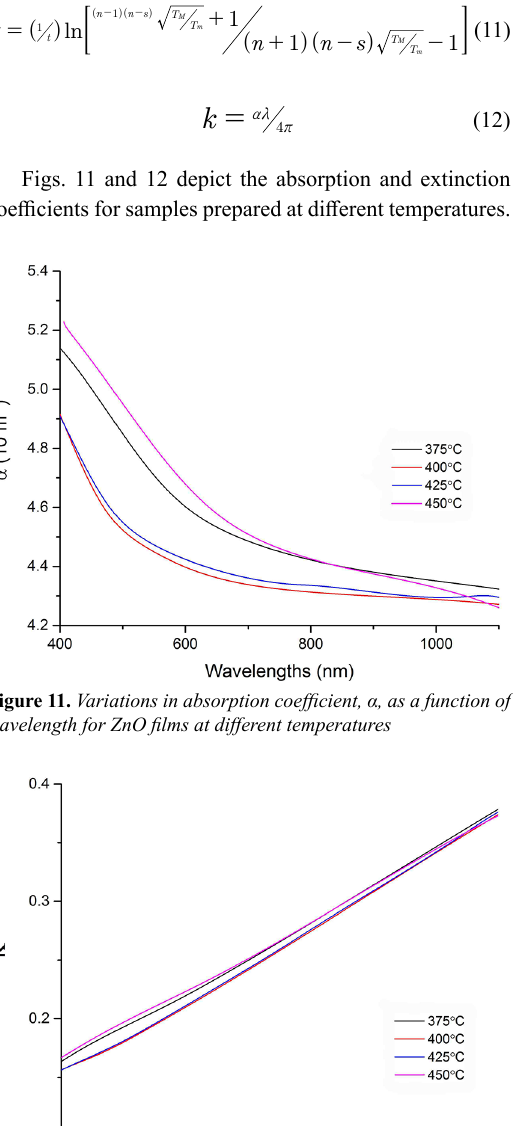
Optical transitions in semiconductor materials take place by direct and indirect transitions. The absorption coefficient, α, for direct transitions is expressed by Tauc's relation 65